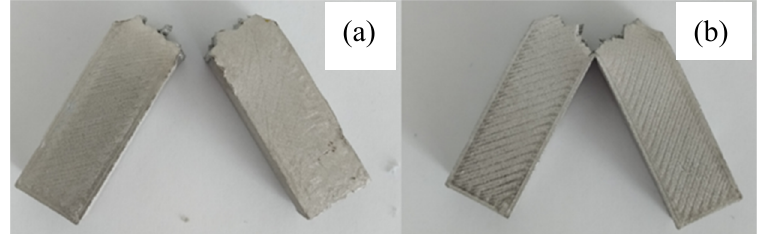
Figure 6. Samples with complete fracture ( a ), samples with partial fracture ( b ).